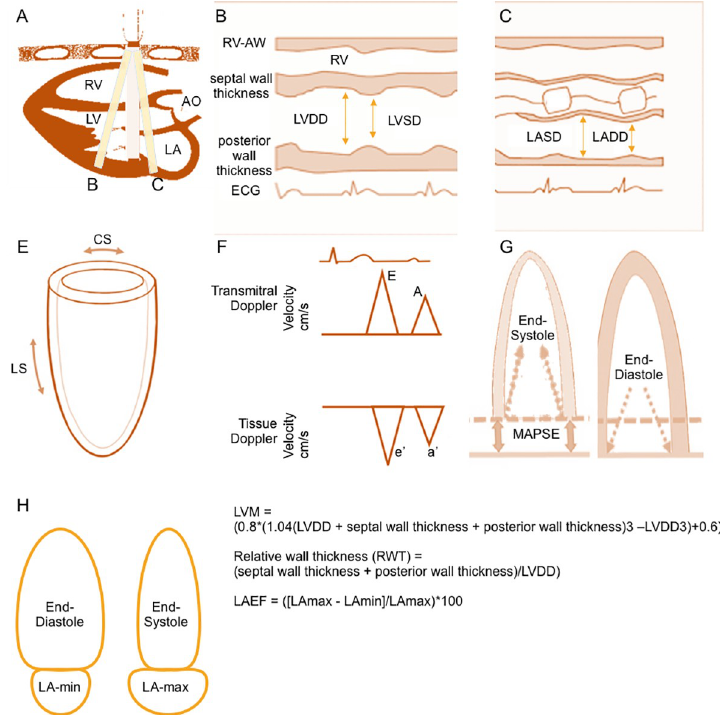
Fig 1. Schematic presentation of the measurement of the investigated echocardiographic measures. Panel A shows a 2D parasternal long axis view, lines B and C indicate the position of the m-mode. The respective m-mode view is shown in panels B and C . Left ventricular end-diastolic dimension (LVDD) and left ventricular end-systolic dimension (LVSD), posterior wall thickness, and septal wall thickness are measured as shown in panel B . Left ventricular mass (LVM), relative wall thickness (RWT) and left ventricular ejection fraction (LVEF) are calculated based on these measures. Left atrial end-systolic dimension (LASD) and left atrial end-diastolic dimension (LADD) are measured as shown in panel C . Panel E depicts the basic directions in which circumferential strain (CS) and longitudinal strain (LS) are measured. Panel F shows the measurements of transmitral Doppler (E and A) and tissue Doppler (e’ and a’) velocities. We have measured early systolic mitral annulus velocity using tissue Doppler imaging at the lateral mitral annulus. E/e’ ratio is calculated based on these measurements. Mitral annular plane systolic excursion (MAPSE) was measured by the systolic excursion of the mitral annulus from its lowest point at end-diastole ( panel G , right) to its highest point at the time of aortic valve closure ( panel G , left) at the lateral side of the mitral valve annulus in the apical four-chamber view. Maximum and minimum volumetric measurements of the LA (LAmax and LAmin) from apical two and four-chamber views were taken at end-diastole for LAmin ( panel H , left) and at end-systole for LAmax ( panel H , right). Left atrial emptying fraction (LAEF) is calculated based on these measurements.